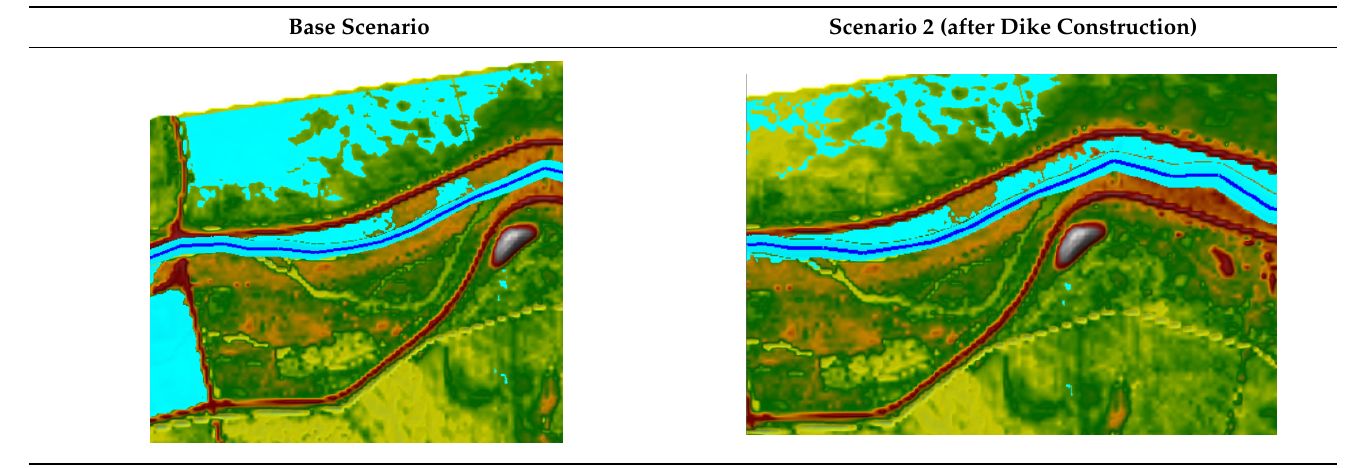
Table 9. Comparison of floodplain inundation between the base scenario and after-dike-construction scenario for sub-reach